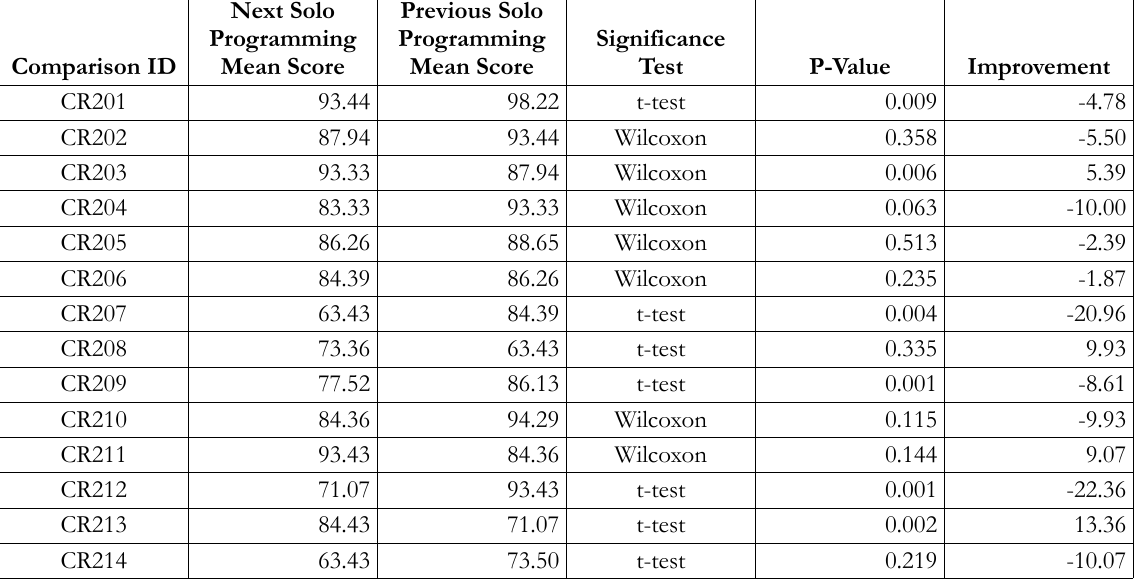
Table 9. The Individual Improvements Gained by Utilising Pair Programming in